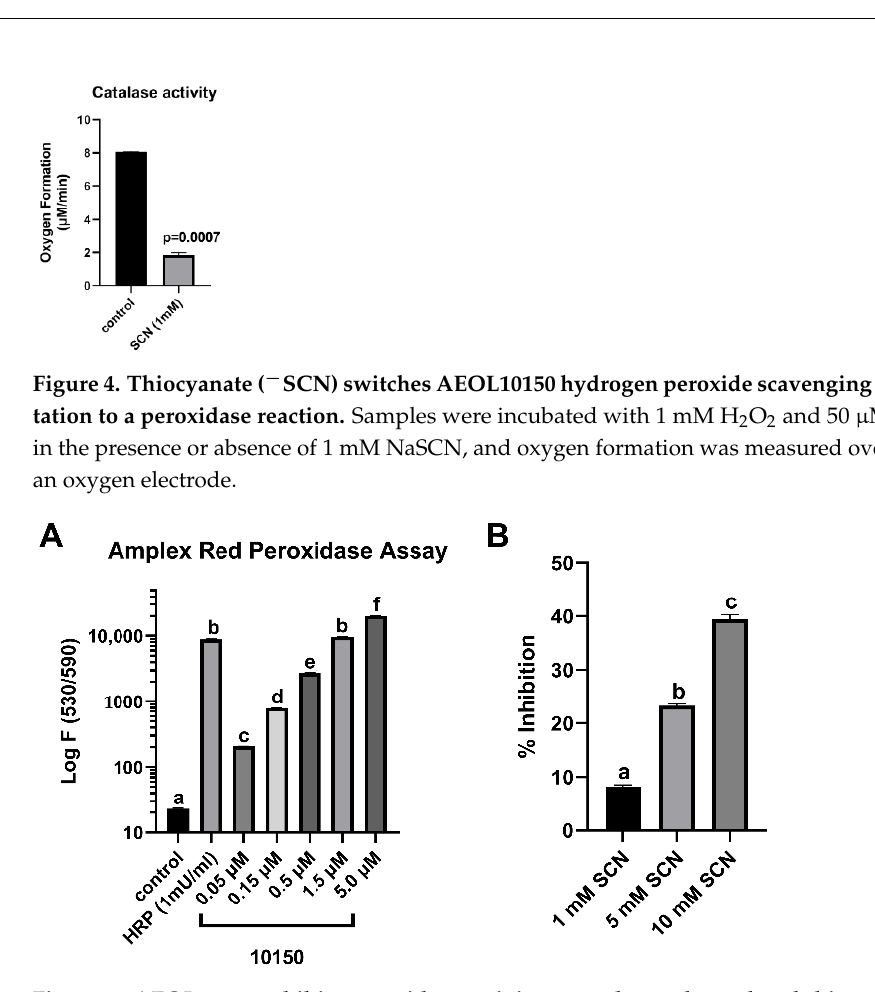
Figure 5. AEOL10150 exhibits peroxidase activity towards amplex red and thiocyanate ( − SCN) . (A) Peroxidase reactions contained amplex red (50 M) and 1 mM hydrogen peroxide (control), and fluorescence was measured after 10 min. ( B ) Peroxidase reactions contained amplex red (50 µ M), hydrogen peroxide (1 mM), and 5 µ M 10150, with increasing concentrations of NaSCN. The percentage of inhibition was calculated from the reactions without NaSCN. Different letters indicate a significant difference between treatment groups; p < 0.05.